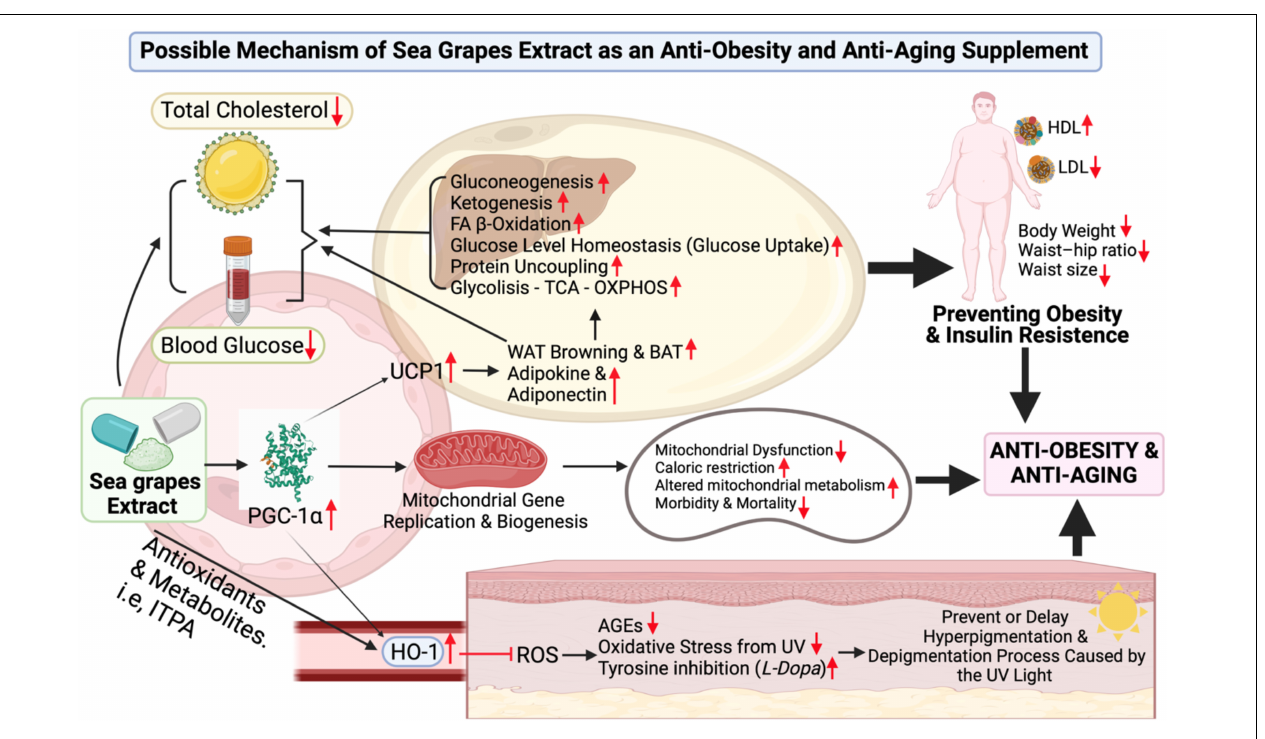
FIGURE 6 | Sea grape extract effect possible-scheme for anti-obesity and anti-aging. Figure legends details directly can be found in the discussion. Abbreviations can be found at the top or title